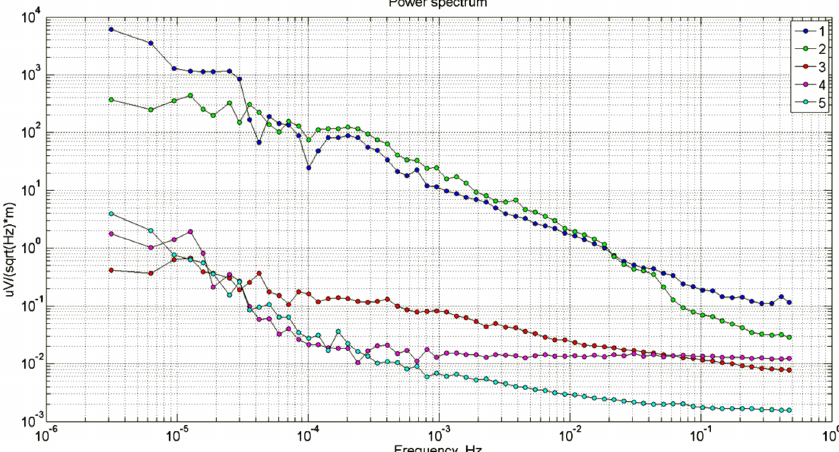
Figure 7. Power spectra of natural signals and instrumental noise levels. Here curves 1 and 2 are measured natural signal spectra along the X and Y components correspondingly. Curves 3 and 4 – noise levels measured with short-circuited inputs for former versions of MT stations and (curve 5) for station LEMI-420, both divided by the same inter-electrode distance as for curves 1 and